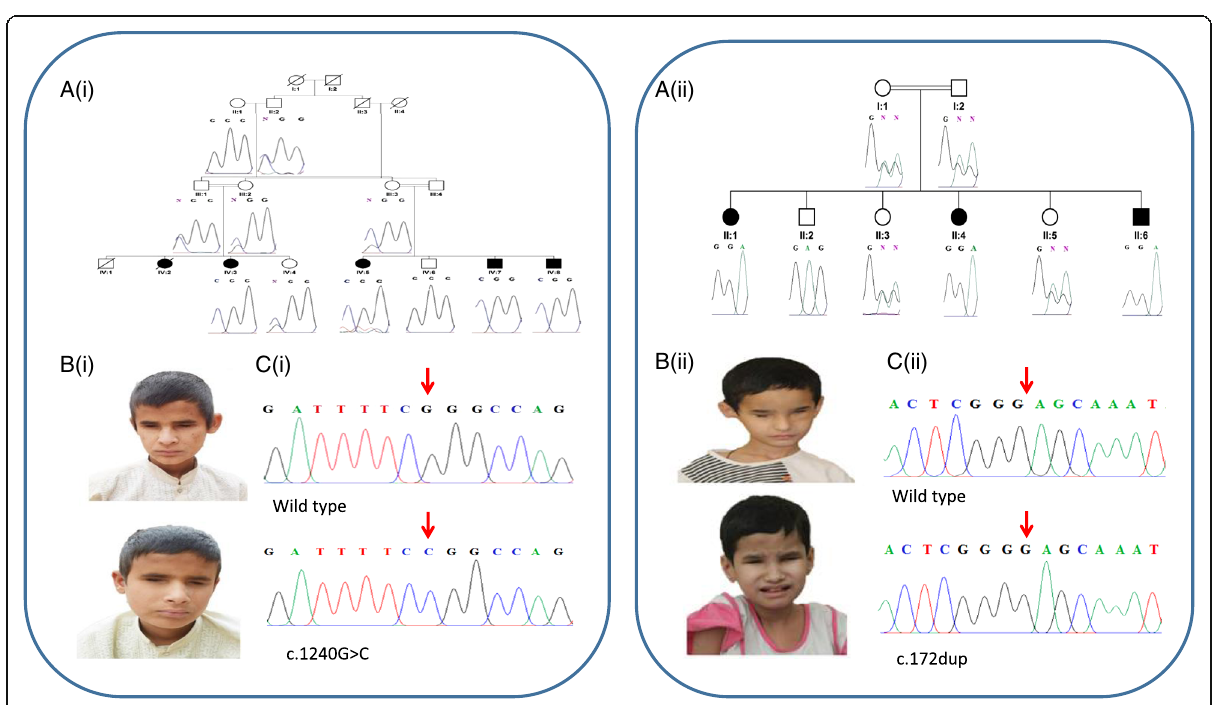
Fig. 1 A Pedigrees of the Pakistani families investigated, and genetic findings. A(i) and A(ii). Family 1 (Ai) and family 2 (Aii) pedigrees showing segregation of the variants identified in each case. B(i) and B(ii). Photographs of two affected individuals in both families with non-syndromic clinical anophthalmia C(i) and C(ii). Sequence chromatograms showing wild-type alongside ALDH1A3 [NM_000693.3:c.1240G > C, p.Gly414Arg; Chr15:101447332G > C (GRCh37)] in exon 11 (family 1), and, a frameshift mutation [NM_000693.3:c.172dup, p.Glu58Glyfs*5; Chr15:101425544dup (GRCh37)]